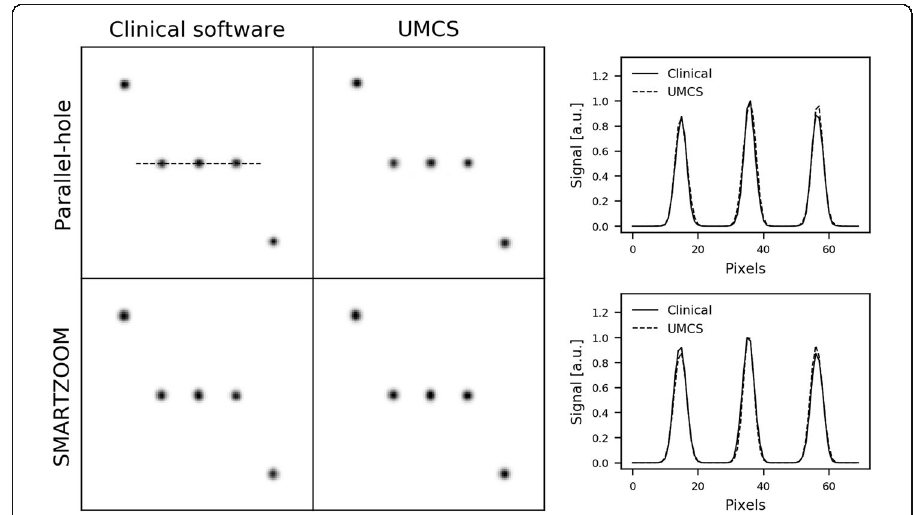
Fig. 4 The reconstructions of the point sources obtained with the parallel-hole and the SMARTZOOM collimator when reconstructed with the clinical software and UMCS shown together with the profile at the location of the dashed line in the upper left reconstruction